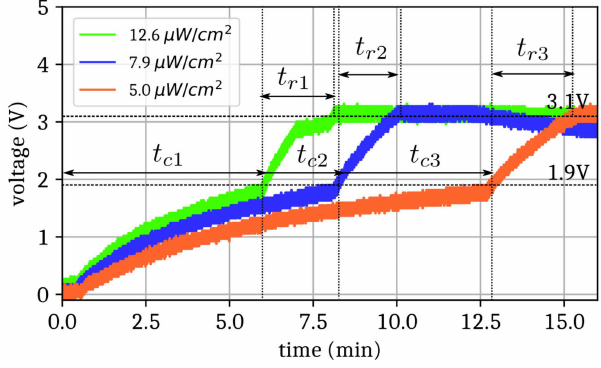
Figure 4. Cold start-up duration (t c ) and charging time (t r ) of the supercapacitor (7 mF) of the PMU for three di ff erent RF power densities: 12.6 µ W / cm 2 (green), 7.9 µ W / cm 2 (red), and 5.0 µ W / cm 2 (blue) measured with an